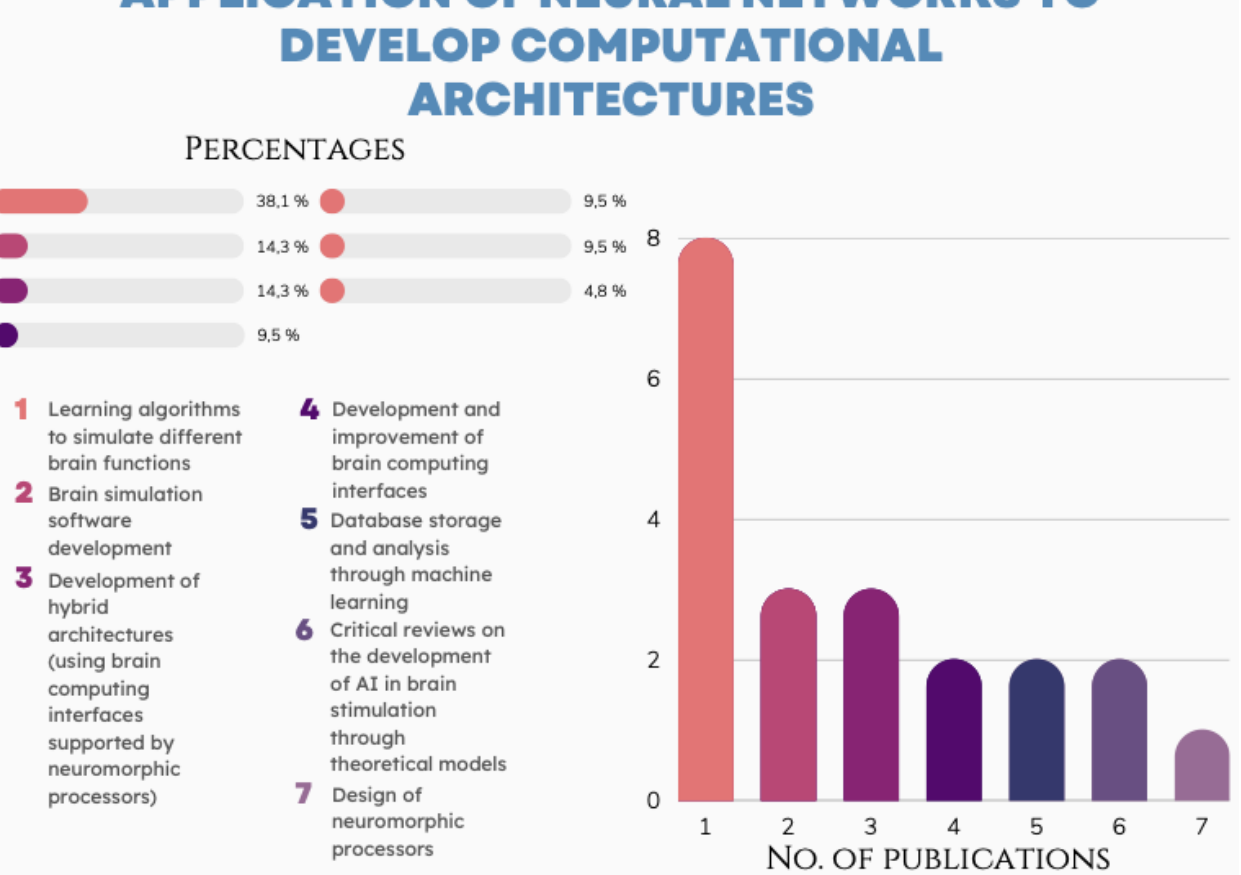
Figure 4. The results of the systematic review of the 21 publications show the main applications for neural networks in the development of computational architectures (7) and the number of studies oriented to each